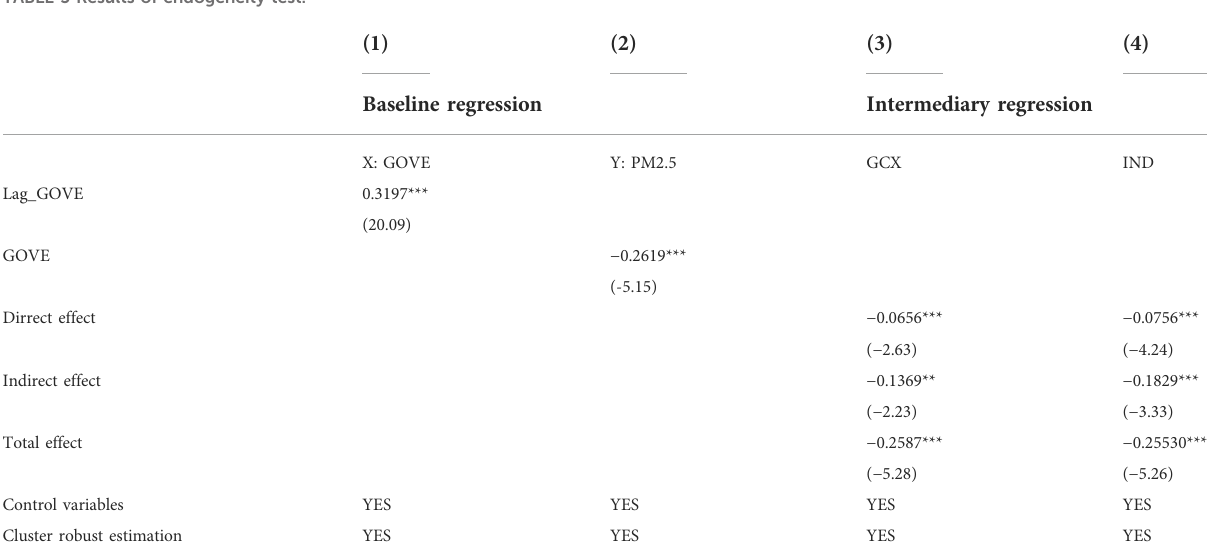
TABLE 5 Results of endogeneity